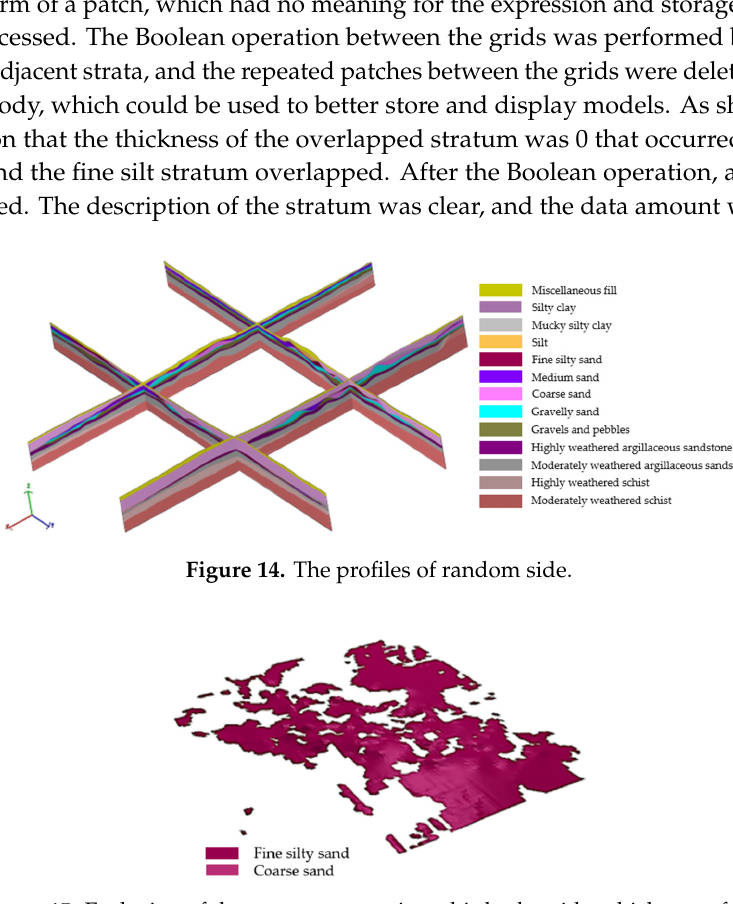
Figure 13. ( a ) Side-view of stratum connection. ( b ) Schematic diagram of connecting borehole points.